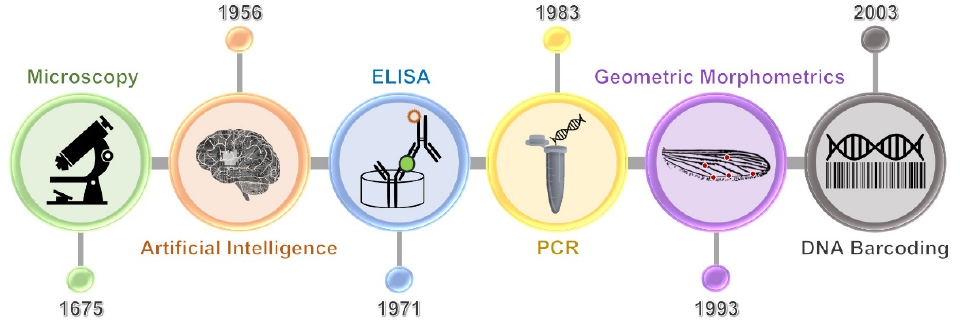
Figure 1. Timeline of technologies for medical parasite and arthropod diagnoses. Microscopy has been applied for pathogen and insect identifications for several centuries. To improve detection efficacy, a range of techniques have emerged. They encompass artificial intelligence, ELISA, PCR, geometric morphometrics, and DNA barcoding techniques. Table 1. Conventional methods for diagnosis of medical parasites and